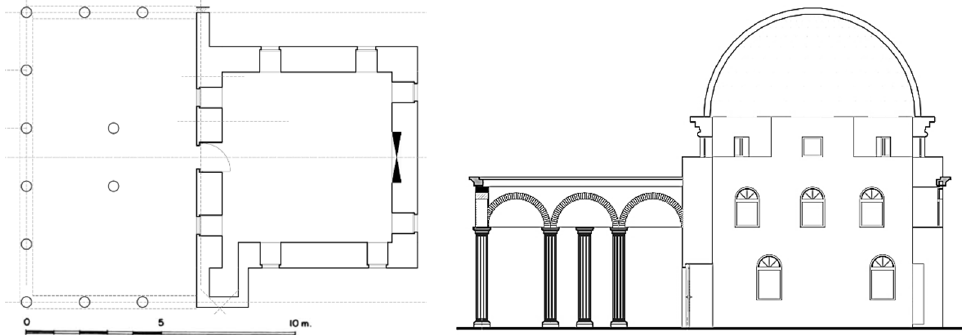
Figure 7. Plan layout ( left ) and section ( right ) of the Kubalie Mosque in Kavaja. Provision courtesy from Arch. Arsim Murseli, UBT University.